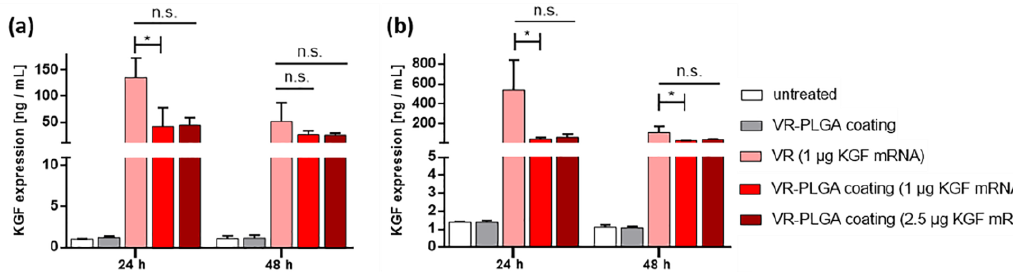
Figure 4. Quantification of the release of KGF protein after the in vitro incubation of cells with mRNA complexes of mRNA-coated sutures. Analysis of KGF secreted by BJ fibroblasts ( a ) or HaCat cells ( b ) 24 or 48 h after transfection via the mRNA-PLGA coating that contained either 1 or 2.5 µg KGF-mRNA. For comparison, the amount of expressed KGF after the direct transfection with 1 µg KGF mRNA was quantified ( n = 4; * p < 0.05, n.s. = not significant)